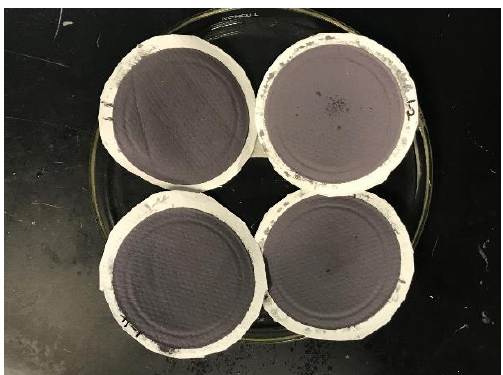
Figure 11. Macroscopic images of membranes covered by various suspension concentrations of ML-Ti 3 C 2 T x.